Question: Looking at the figure, what chart type is it?
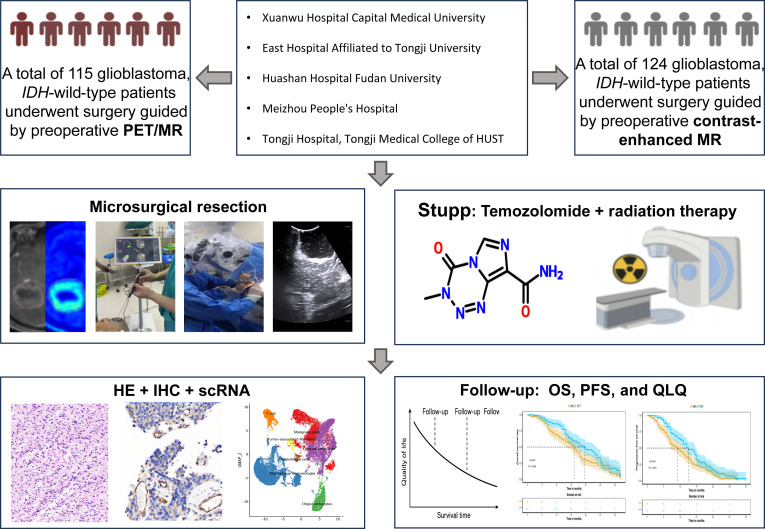
Answer: survival